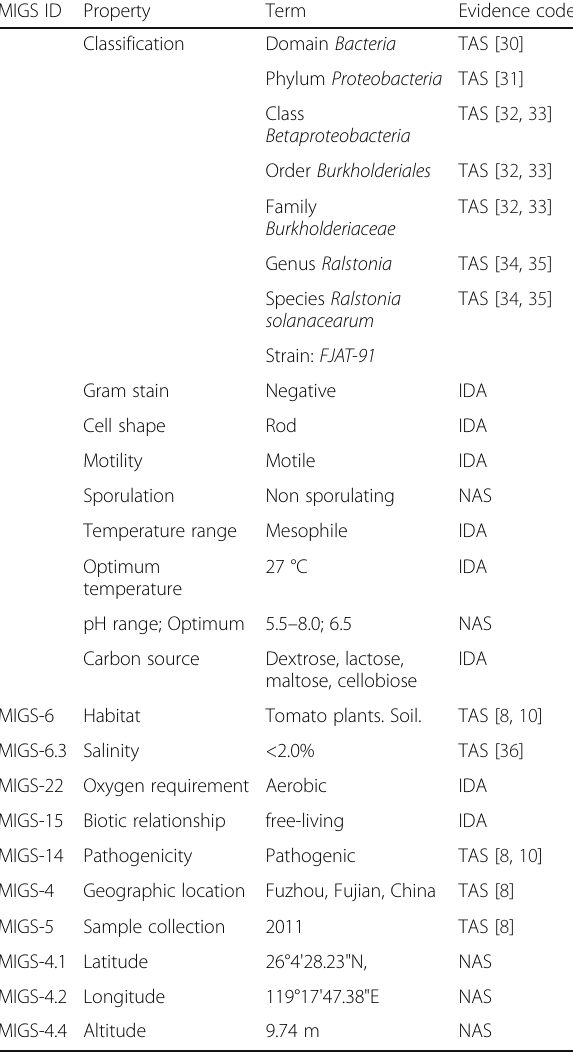
Table 1 Classification and general features of Ralstonia solanacearum FJAT-91 strain according to the